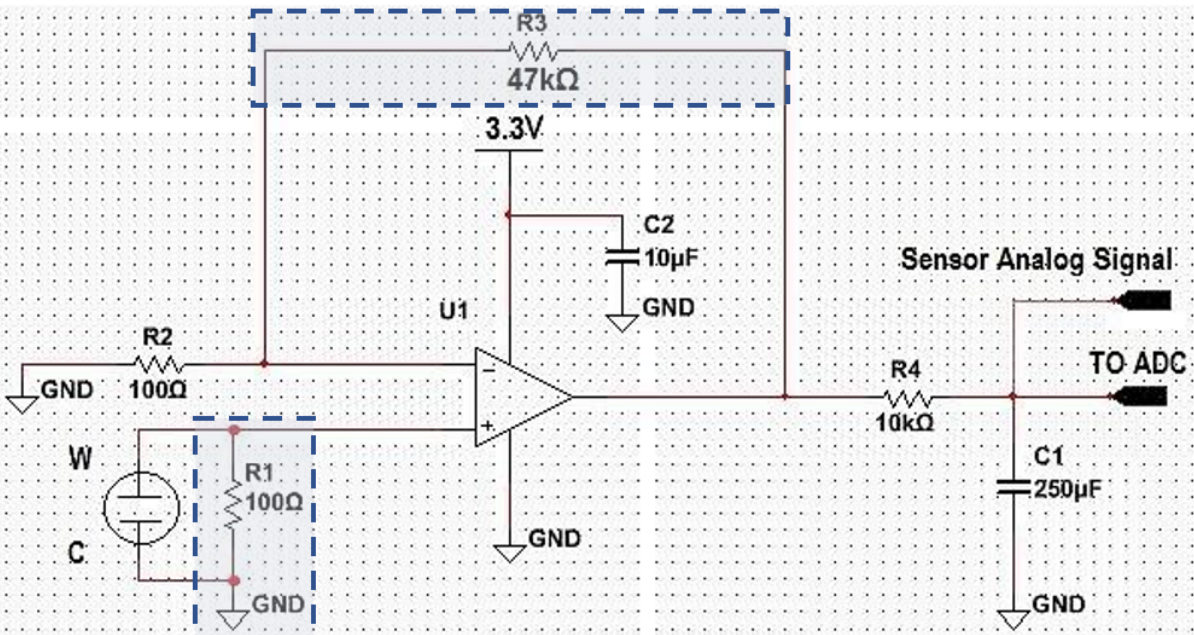
Figure 10. Circuit scheme of the conditioning section for the ME2-O2 gas sensor.